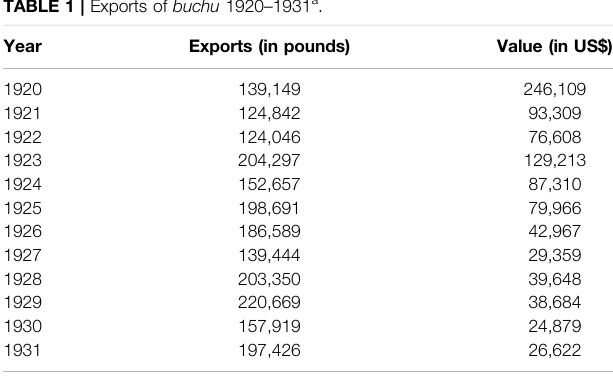
TABLE 1 | Exports of buchu 1920 – 1931 a